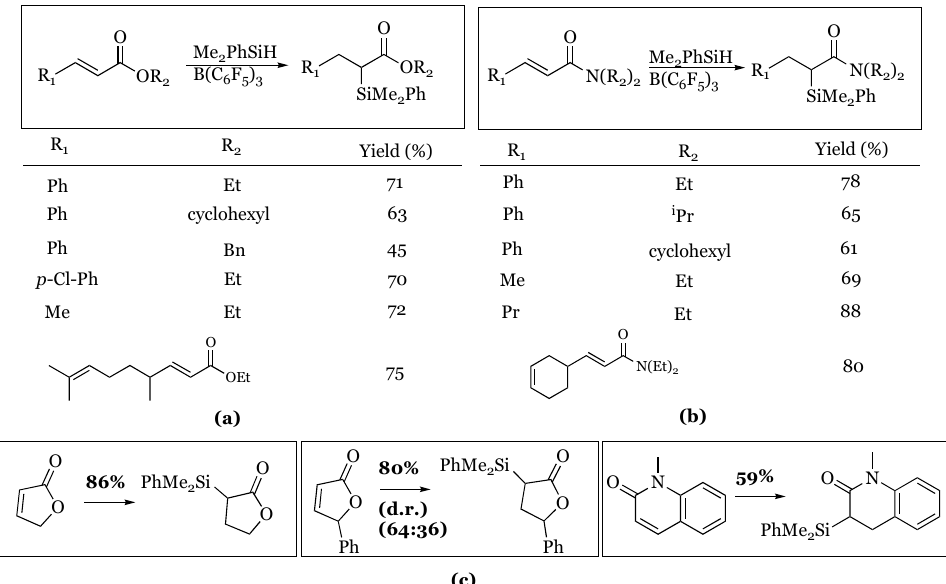
Figure 20. Selective conjugate reduction of α , β -unsaturated esters ( a ); amides ( b ); lactones/lactams ( c ).